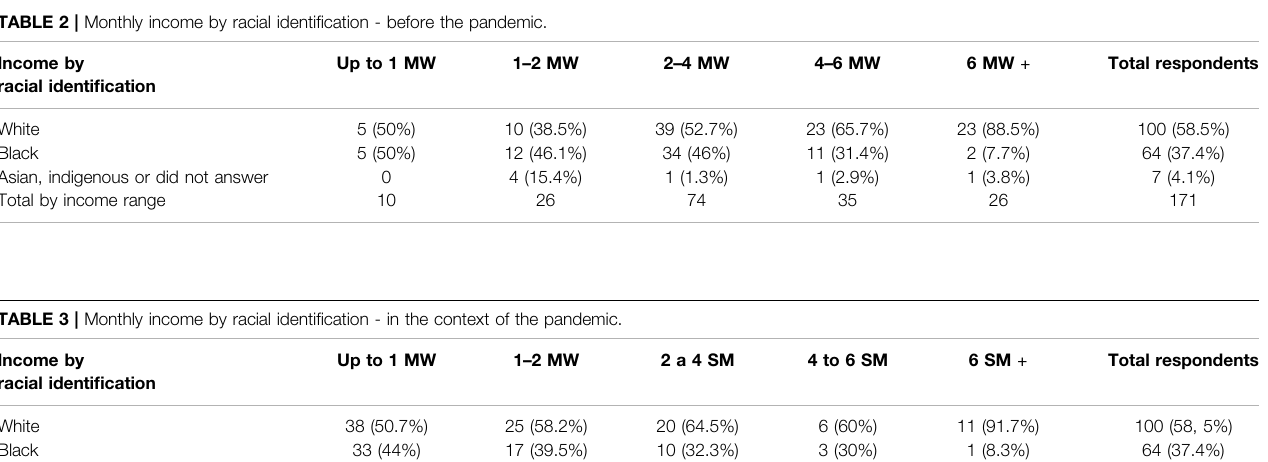
TABLE 2 | Monthly income by racial identi fi cation - before the pandemic. Income by racial identi fi cation